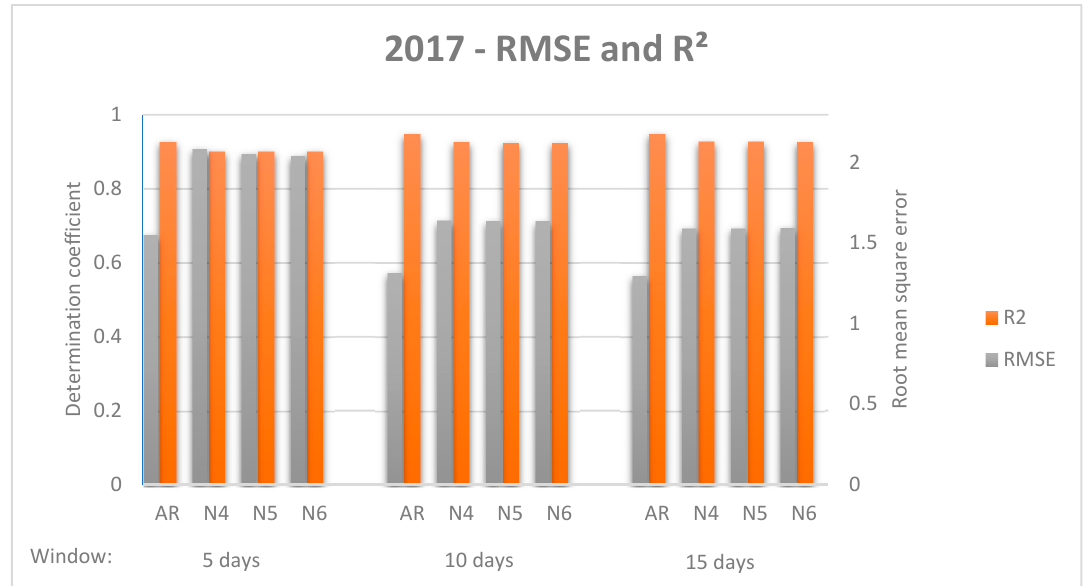
Figure 5. Comparison of forecasting models with different windows for data 2017. Root mean square error and coefficient of determination for each model and window are shown.